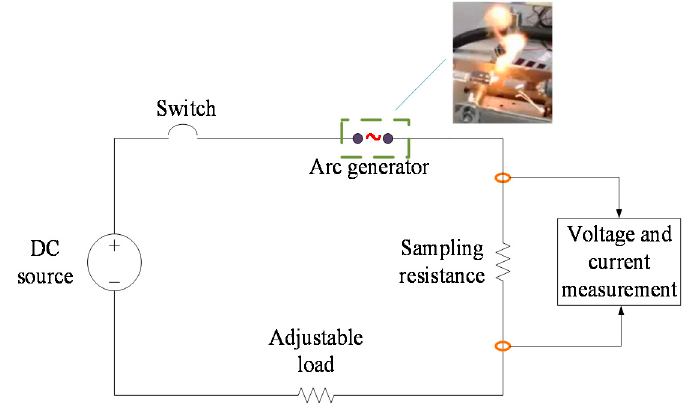
Figure 7. Schematic diagram of the DC series arc fault experimental platform.